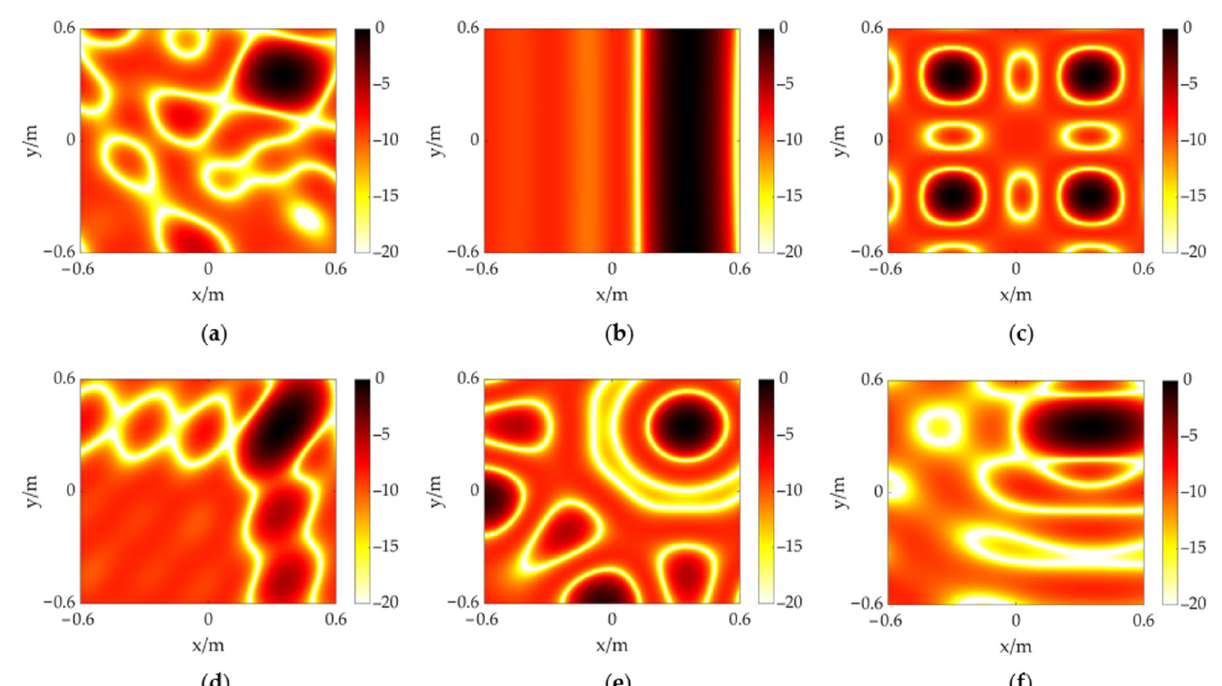
Figure 3. The CSIF results of different topologies at 3 m away from an acoustic source at (0.35, 0.35). ( a ) proposed random topology; ( b ) line topology; ( c ) rectangular topology; ( d ) L-shaped topology; ( e ) circular topology; ( f ) semi-circular topology.